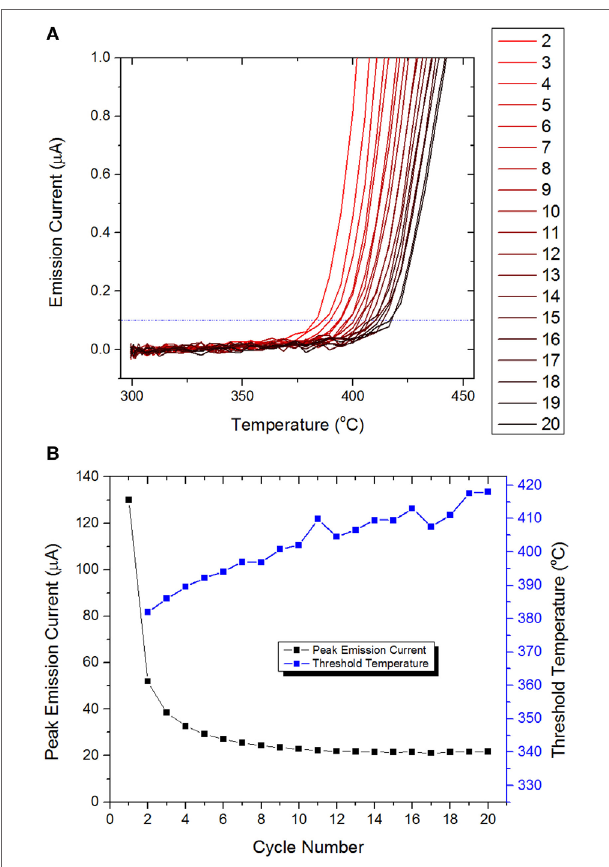
FigUre 4 | Example characteristics for emission current as a function of temperature (a) and the peak emission current and threshold temperature as a function of cycle number (B) , from a sample in set A. T was cycled between 300 and 600 °C over a period of 40 min. Threshold temperature is defined where the current increases past 0.1 µA, shown by the blue dashed line.